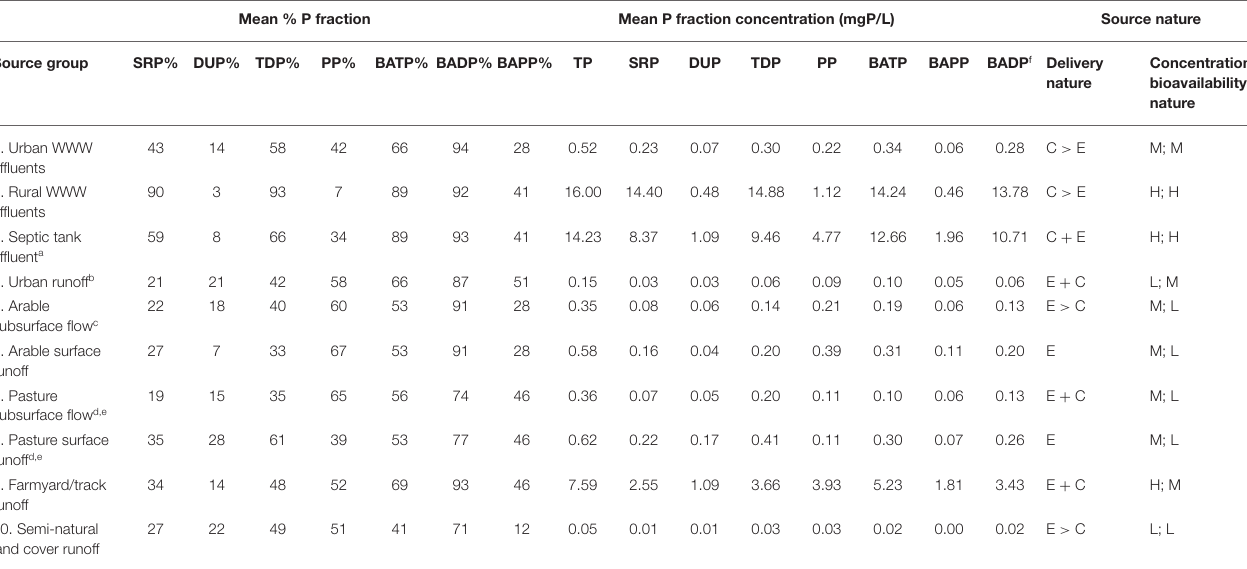
TABLE 2 | Summary of literature-derived data on catchment source P chemistry, including dissolved and particulate fractions and their bioavailability from reported assays and interpretation of source behaviours.